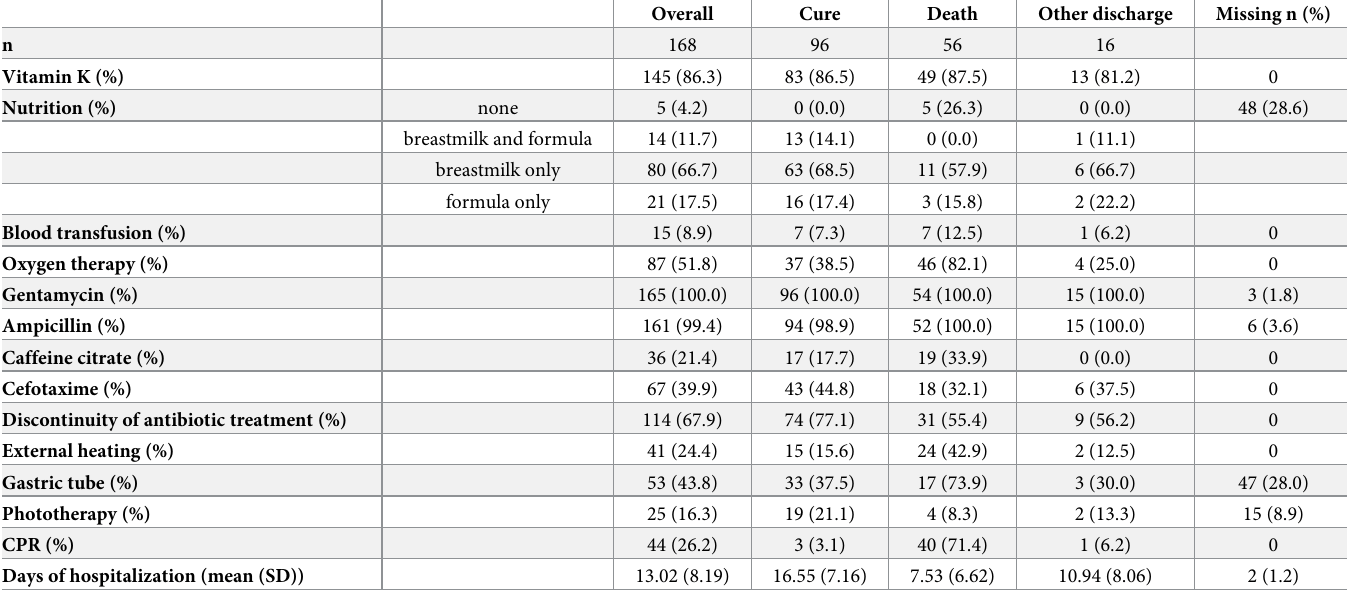
Table 7. The most common treatments of newborns admitted to INSE, stratified by neonatal outcomes (cure or death during hospital stay or other discharge).